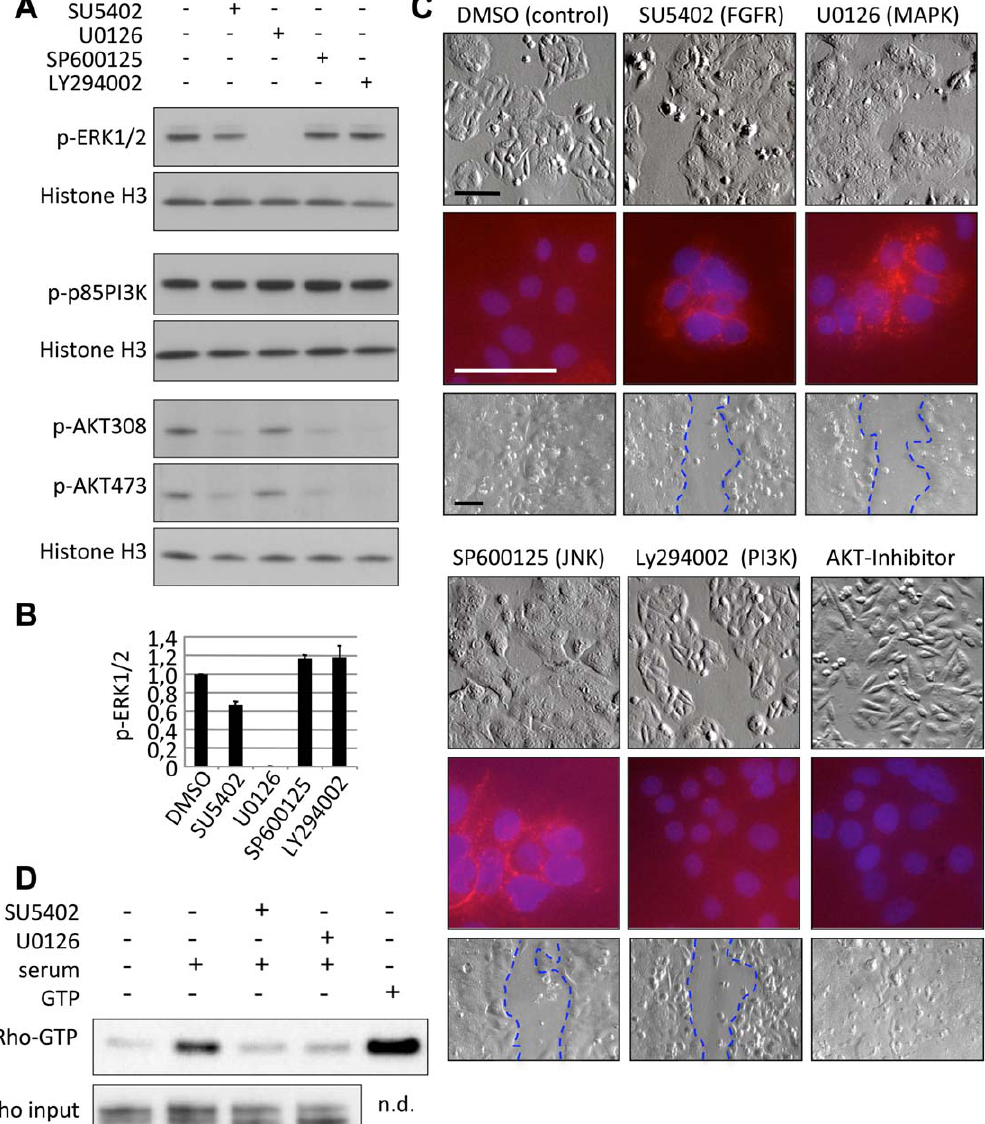
Figure 4. FGF receptor signals for epithelialization are transmitted via MEK1/2 and Rho. A Analysis of Phospho-ERK1/2, Phospho-P85PI3K and Phospho-AKT in SW480 cells after treatment with DMSO (solvent control), SU5402 (inhibiting FGFR), U0126 (inhibiting MEK1/2 dependent ERK1/2 phosphorylation), SP600125 (inhibiting JNK), and Ly294002 (inhibiting PI3K-mediated AKT phosphorylation) are shown. Histone H3 is shown as loading control. Phosphorylation status was assessed 40 minutes after inhibitor treatment. B Quantification of ERK1/2 phosphorylation, mean of three experiments. C Morphology, E-cadherin immunofluorescence and cell motility of SW480 cells after 72 h of inhibitor treatment. Inhibition of the classical MAPK or alternative MAPK/JNK cascades induced a similar phenotype as FGFR inhibition in SW480 cells, wheras inhibition of PI3K or AKT had no such effect. We found that PI3K inhibition, but not AKT inhibition, inhibits cell motility. Uncoupling of PI3K and AKT signals has been observed before in tumors [56]. Scratch assay was done as in Fig. 3B. Scale bars represent 50 m m. D Inhibition of FGF receptors or MEK1/2 leads to reduced